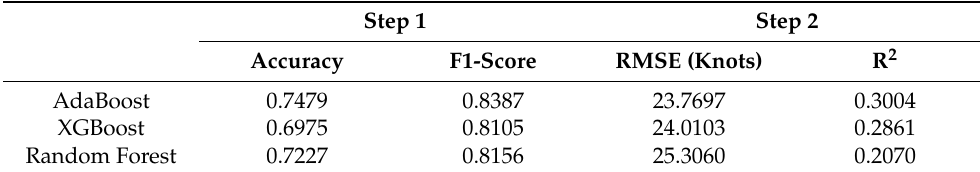
Table 5. Best results of fitting by three ensemble methods in steps 1 and